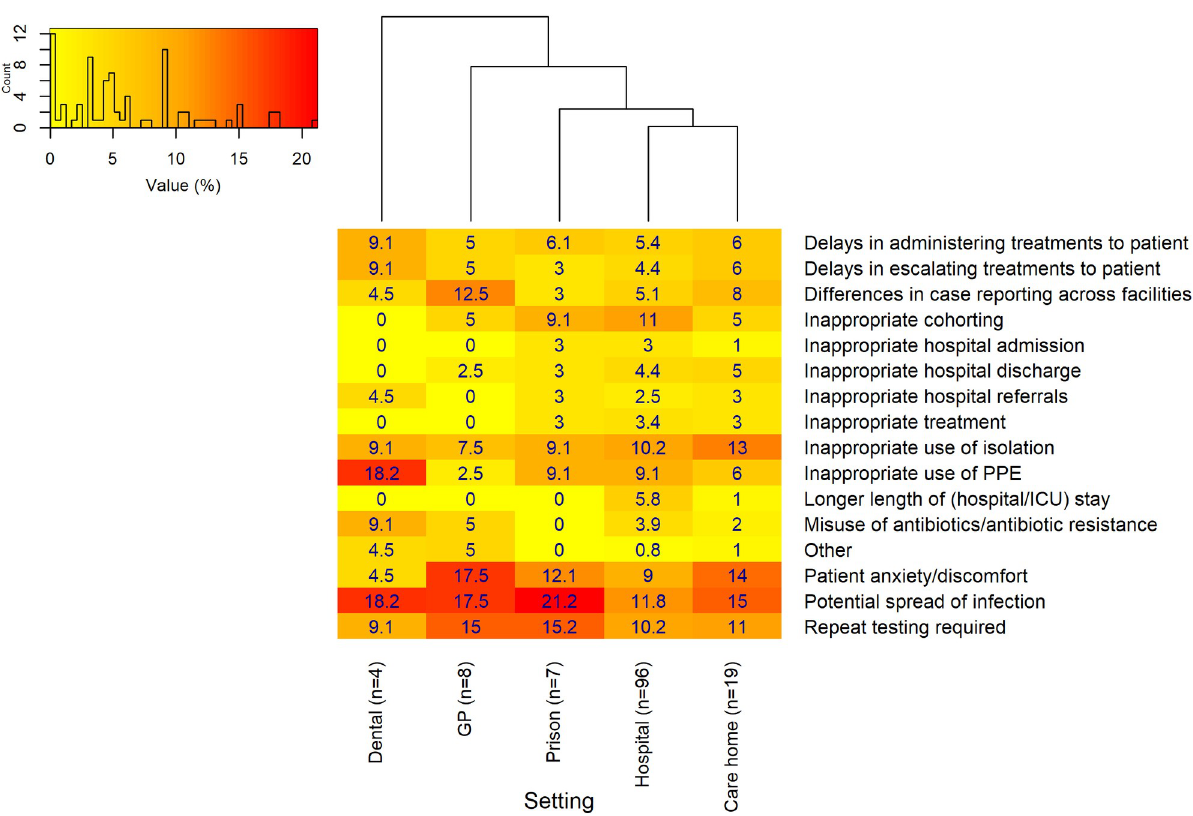
Fig 6. Perceived consequences related to the problems associated with COVID-19 testing in each setting. Primary and secondary dental settings were merged, in addition to care homes with and without nursing. The ‘Hospital-at-home’, hospice and ambulance setting (n < 15) were excluded due to the small number of overall respondents. A hierarchical cluster analysis indicates how similar/dissimilar the perceived consequences related to the problems associated with COVID-19 testing are between settings. The numbers of responses from individual settings for this particular question are displayed on the x axis (n = x). The histogram in the top left of the plot area shows the distribution of values, and provides a key to indicate the specific color shade of different